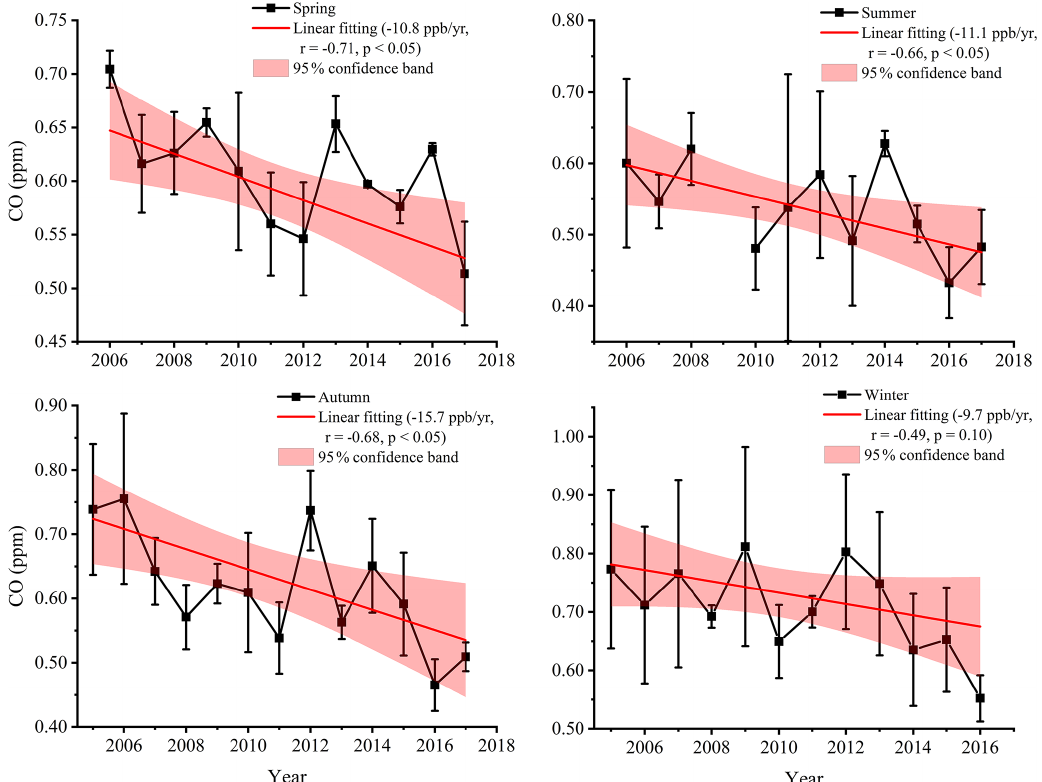
Figure 7. Seasonal time series and linear fitting of CO mixing ratios at the LAN station (spring: March to May, summer: June to August, autumn: September to November, and winter: December to February).